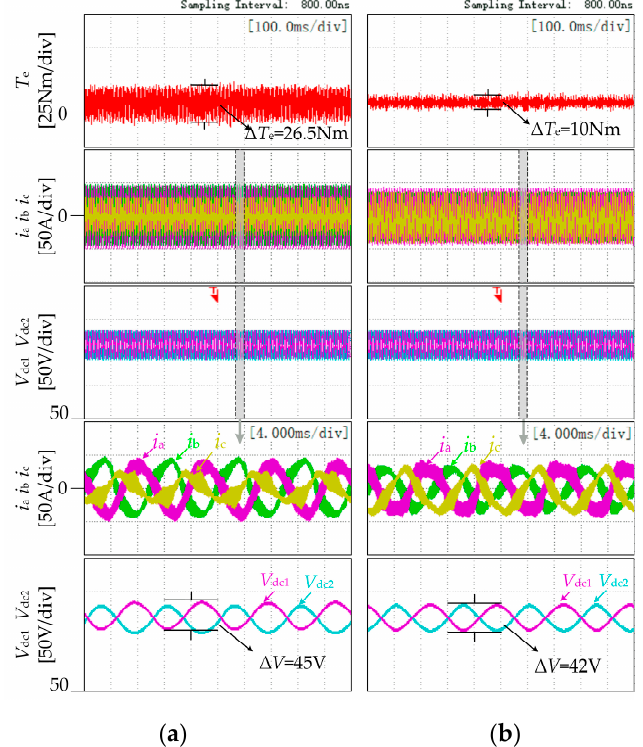
Figure 8. Experimental results at 1500 r/min and 10 Nm: ( a ) without capacitor voltage offset suppression; ( b ) proposed method.